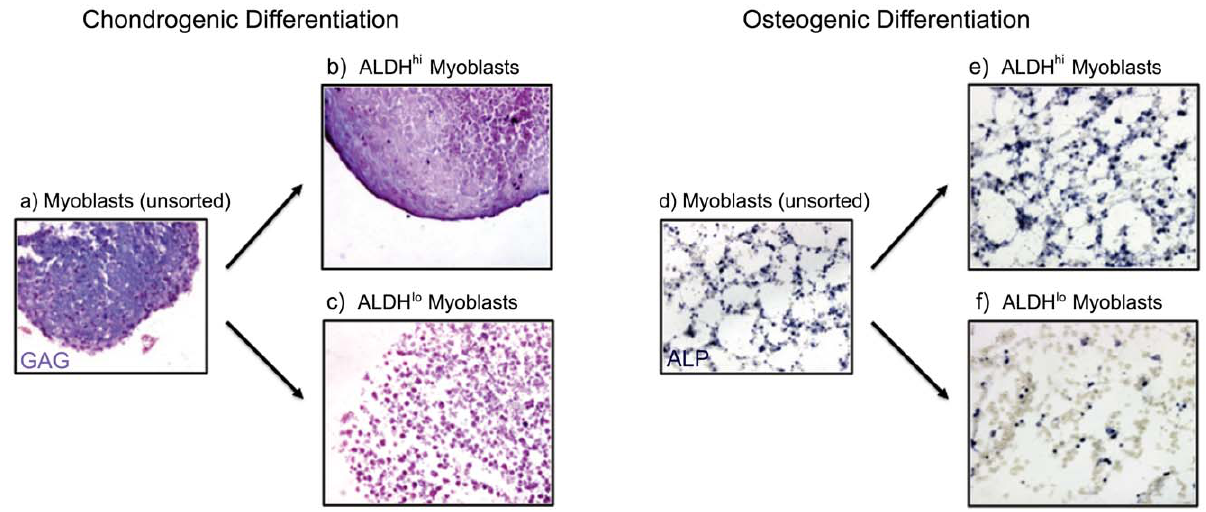
Figure 4. Chondrogenic and osteogenic potential of ALDH hi myoblasts. (a–c) Chondrogenic differentiation in ALDH sorted myoblasts was induced via a pellet system containing TGF. Rapid proliferation and chondrogenic pellet formation was observed in ALDH hi myoblasts (24 hrs) with robust production of glycosaminoglycans (GAGs), visualized via Alcian blue staining. This is in contrast to the poor proliferation and GAG production of ALDH lo myoblasts. This result suggests that the chondrogenic differentiation capacity of unsorted myoblasts is dominated by ALDH hi myoblasts. (d–f) Osteogenic differentiation of ALDH sorted myoblasts was induced in vitro by BMP-4 stimulation. Alkaline phosphatase levels (ALP, shown in blue), an early marker of osteogenic differentiation were significantly increased in ALDH hi myoblasts compared to ALDH lo myoblasts after a period of 4 d of BMP-4 stimulation.